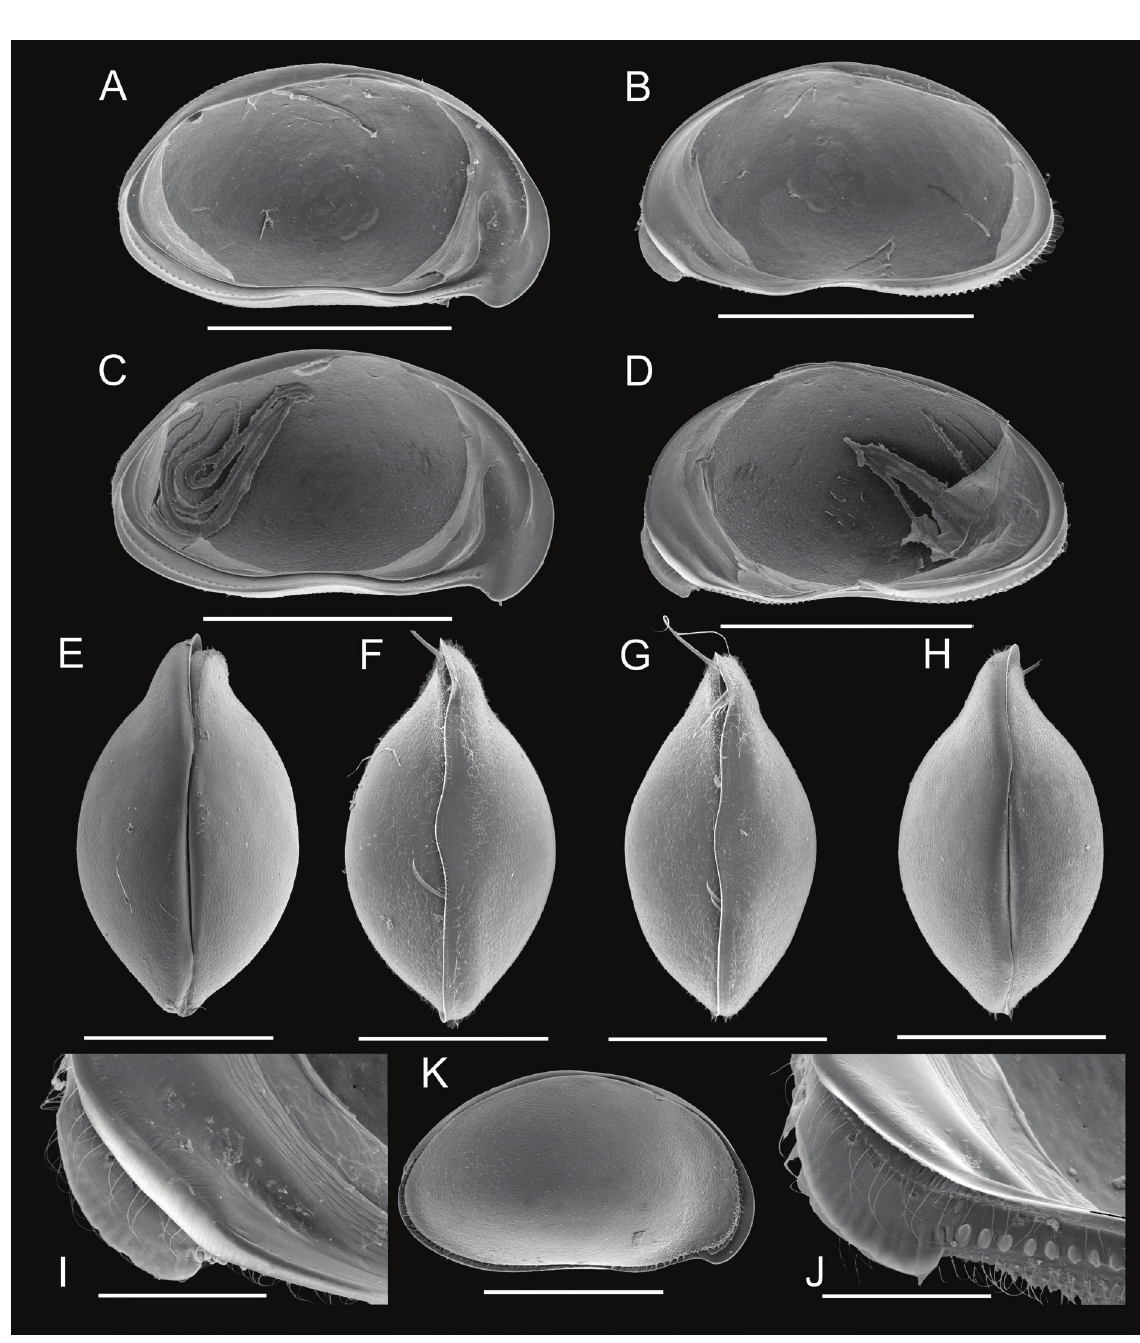
Fig. 16. Bennelongia lata sp. nov. (all from Yandoo Billabong, type locality). A . LVi (allotype ♀, WAM. C49400). B . RVi (♀, Idem). C . LVi (♂, WAM.C49401). D . RVi (♂, Idem). E . Cp dorsal (♀, specimen lost). F . Cp ventral (♀, WAM.C49402A). G . Cp ventral (♂, WAM.C49402B). H . Cp dorsal (♂, WAM. C49402C). I . RVi (detail anteriorly, allotype ♀, WAM.C49400). J . rVi (detail anteriorly, tilted, allotype ♀, WAM.C49400). K . Cp RL view (♀, specimen lost). Scales: A-H, K = 1000 µm; I, J = 200